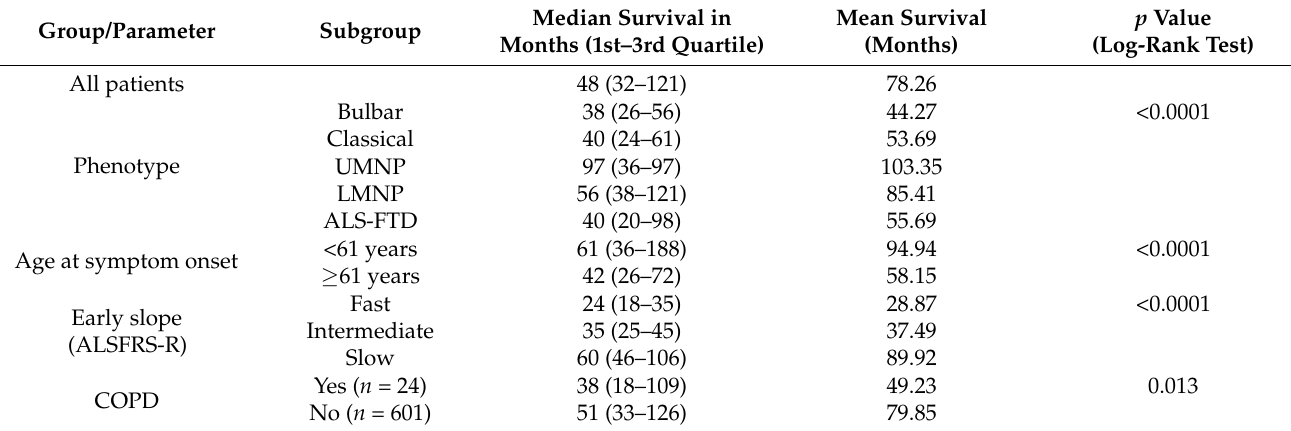
Table 4. Median survival time from symptom onset.